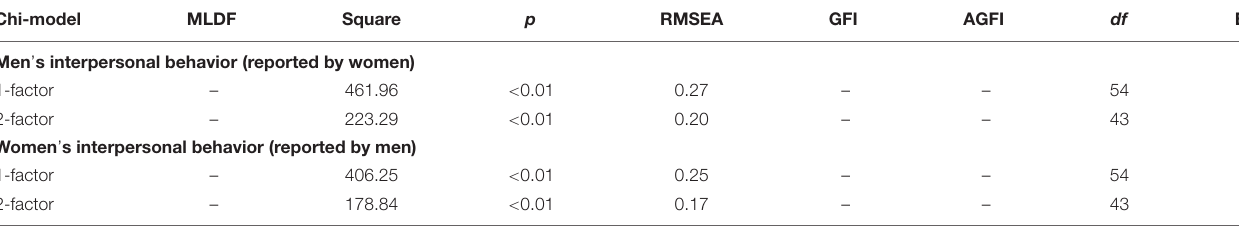
TABLE 1 | Decision tables for number of interpersonal behavior factors in the pilot study ( N = 106 couples). a